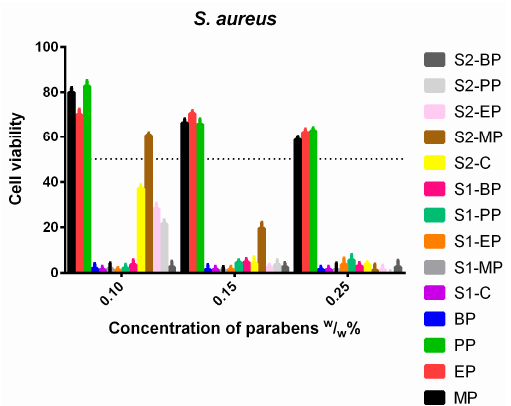
Figure 11. Cell viability of S. aureus against the control paraben solutions (MP; EP; PP; BP); the first system (S1-MP; S1-EP; S1-PP; S1-BP) and the second system (S2-MP; S2-EP; S2-PP; S2-BP). Cell viability